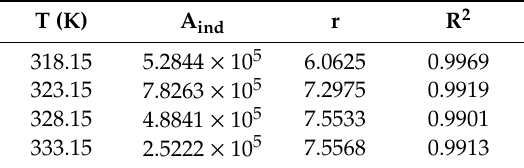
Table 2. The parameters of empirical Equation (19) at di ff erent temperatures.